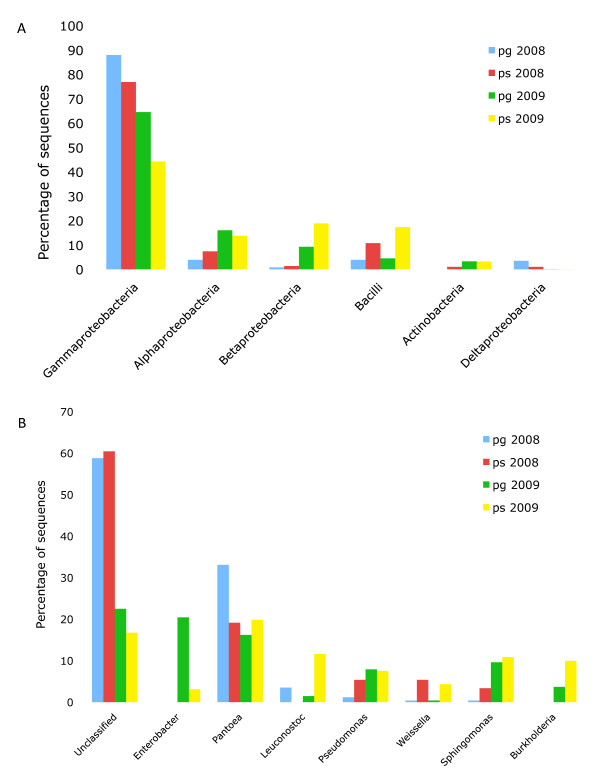
Most abundant bacterial classes and genera in tomato fruit surface samples (2008 and 2009). A) Bacterial classes in surface and groundwater treated fruit surfaces, indicating a predominance of Gammaproteobacteria in both years. B) Bacterial genera in surface and groundwater treated fruit surfaces.